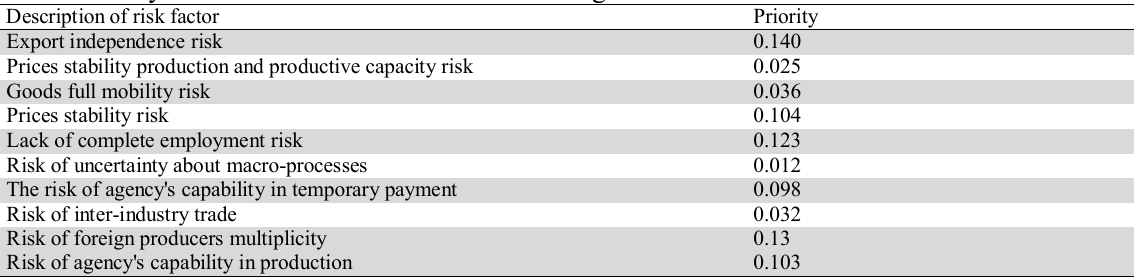
The summary of risk factors associated with exchange